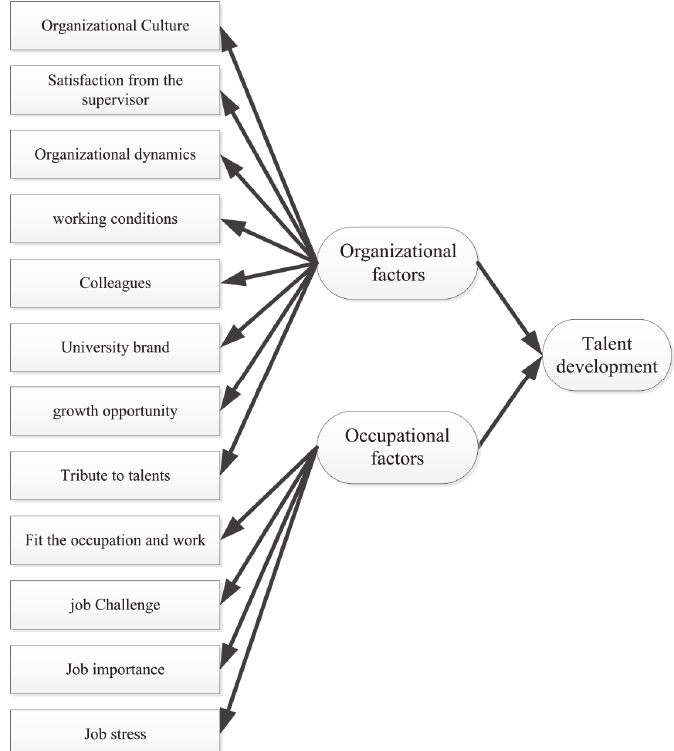
Fig. 2. The basic research